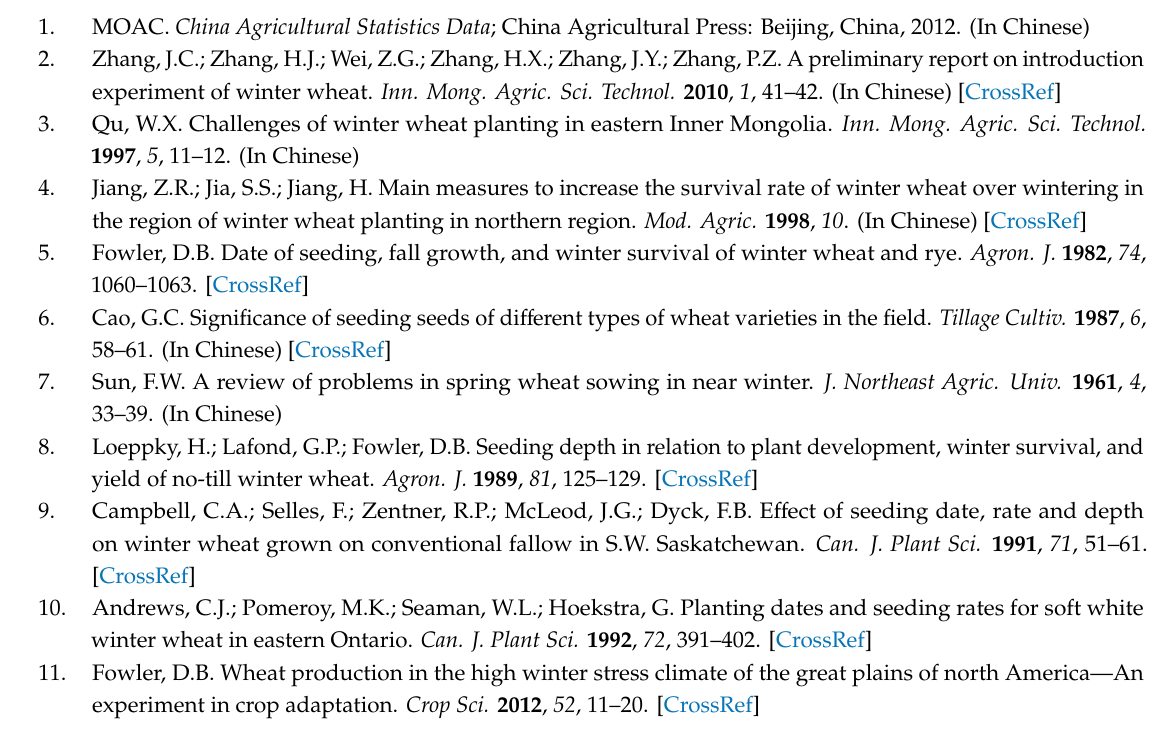
Figure S1: Changes in soil temperature during the three years of the experiment, Table S1: Variation of soil moisture content (%) at 0–20 cm during the